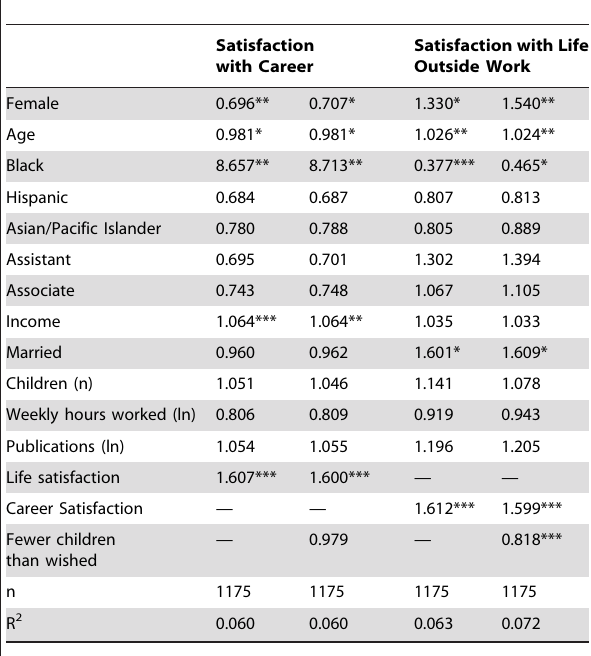
Table 2. Logistic Regression of Faculty Satisfaction With Career and Life. 1